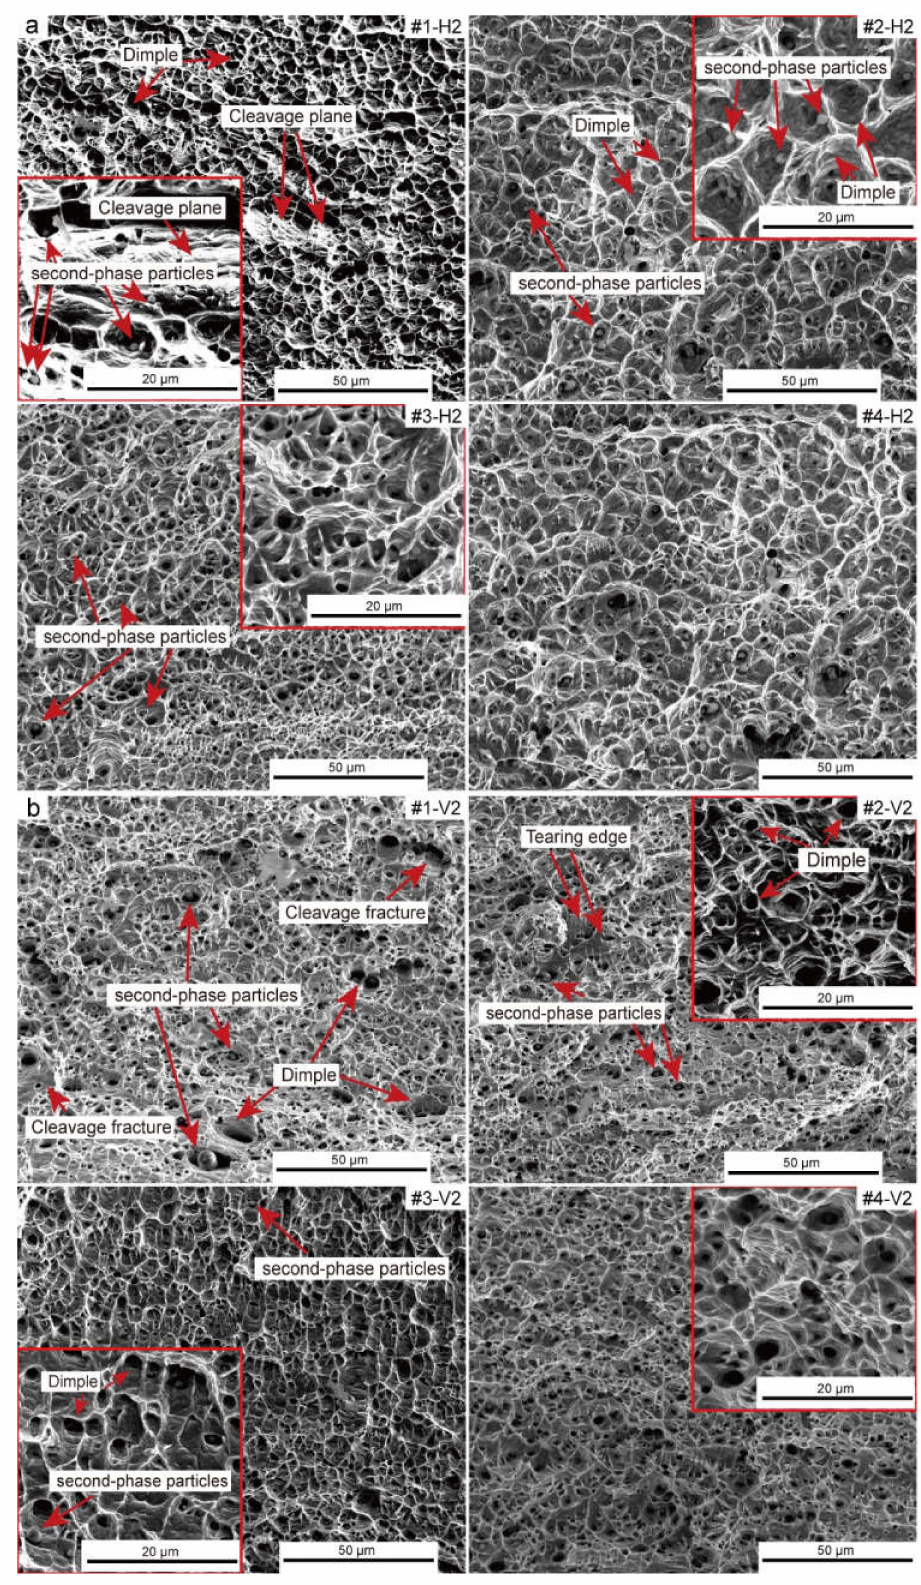
Figure 15. Microscopic fracture morphologies of tensile specimens in horizontal and vertical